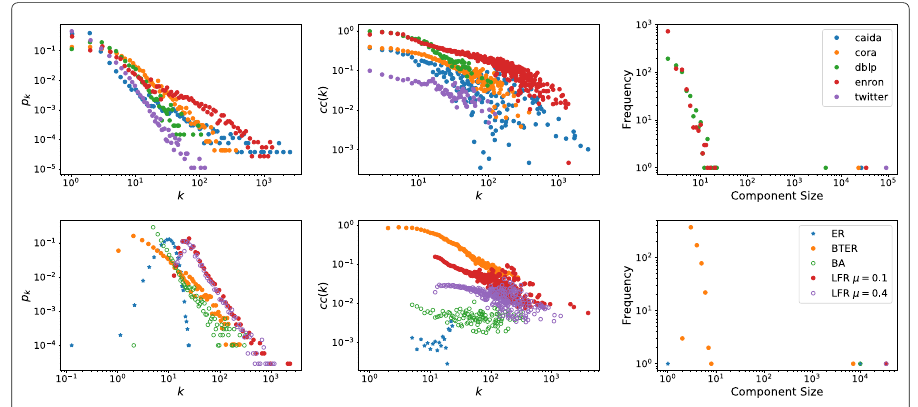
Fig. 2 The top row from left to right shows the (node) degree distribution, average (node) clustering coefficient per degree, and frequency of connected component sizes of five real-world networks. The bottom row shows the same quantities, but for three synthetic graph models: Erdös-Rényi (ER)(Erdös and Rényi 1959), Barabási-Albert (BA) (Albert and Barabási 2002), and Block Two-Level Erdös-Rényi (BTER) (Seshadhri et al. 2012). NOL-HTR is able to learn to increase network size on BTER and similar real-world networks. We find that degree, clustering coefficient, and size of the connected component are all relevant, as well as interpretable, features for